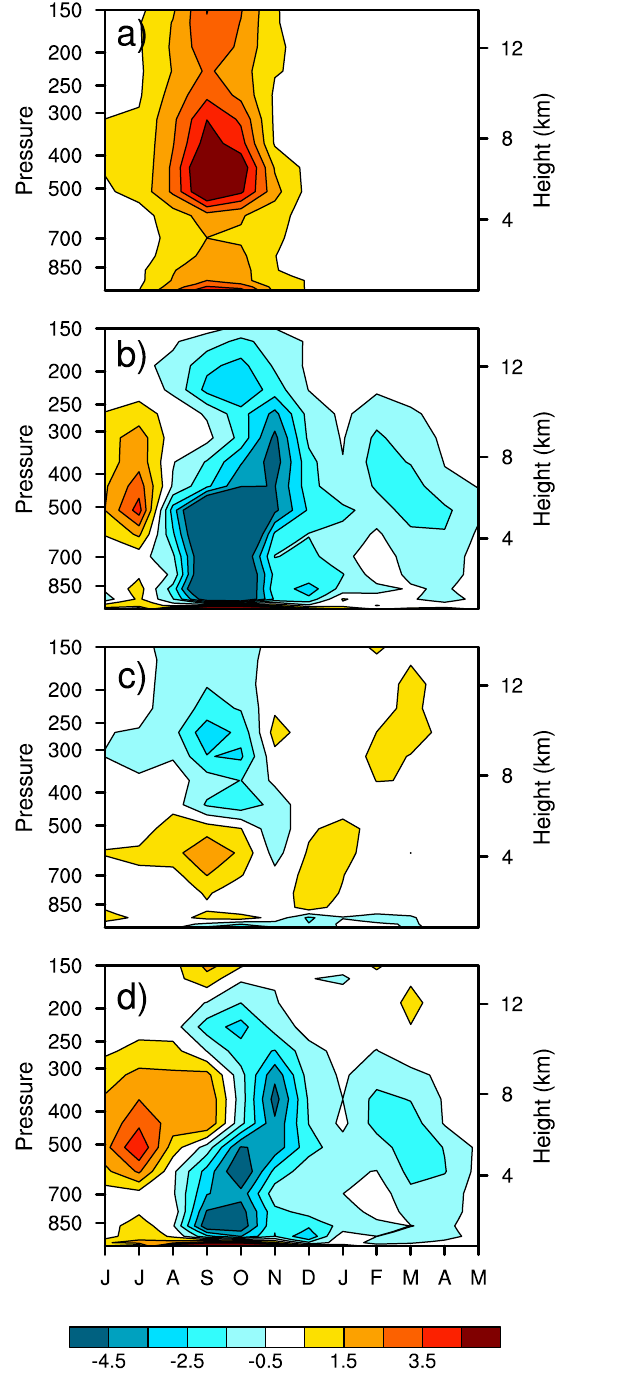
Fig. 6. Fire-induced anomalies in the (a) shortwave warming rate ( ◦ C day − 1 ), (b) condensational warming rate ( ◦ C day − 1 ), (c) long- wave warming rate ( ◦ C day − 1 ), and (d) the sum of shortwave, con- densational and longwave components (sum of panels a–c above; units of ◦ C day − 1 ). The plots show the mean model response for the 90 ◦ E–120 ◦ , 5 ◦ S–5 ◦ N region for an annual cycle beginning in June and ending in May